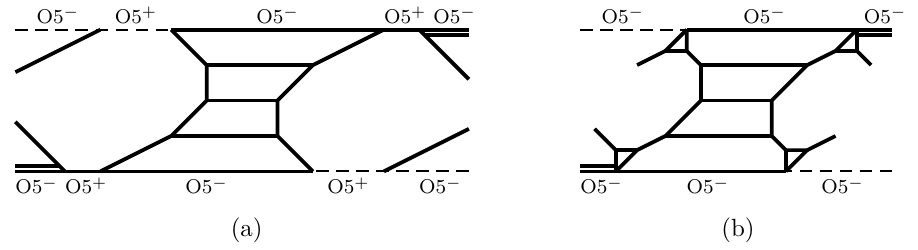
Figure 6. A 5-brane web diagram for Z 2 twisted compactification of 6d SO(8) theory with four auxiliary